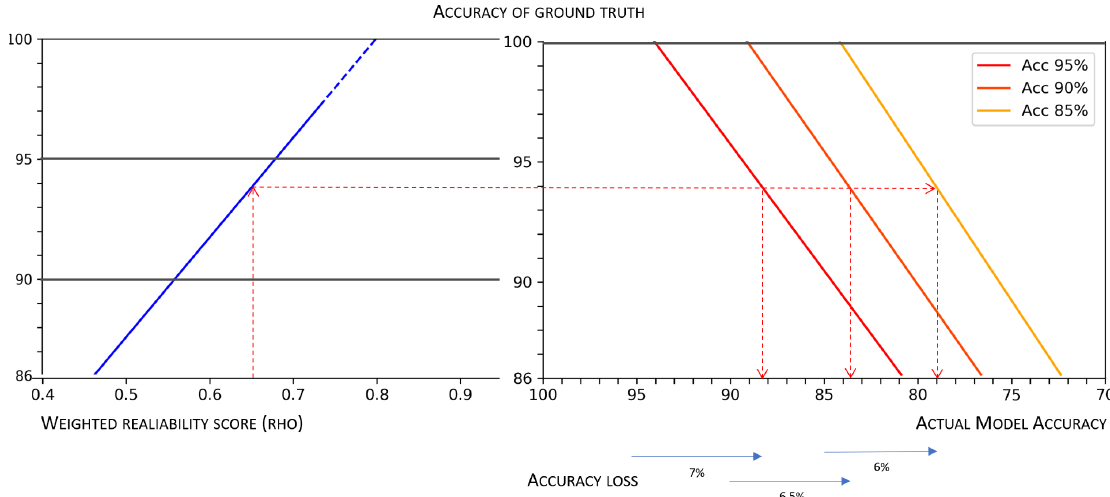
Figure 9. Representation of the relationship between the multi-rater reliability (measured as (cid:36) ), the accuracy of the ground truth, and the actual accuracy of an ML model trained on that ground truth. The figure can be used as a sort of nomogram: given the level of reliability for a given ground truth and the accuracy of an ML model on such a ground truth; the diagram can be used to obtain an estimate of the actual accuracy of the